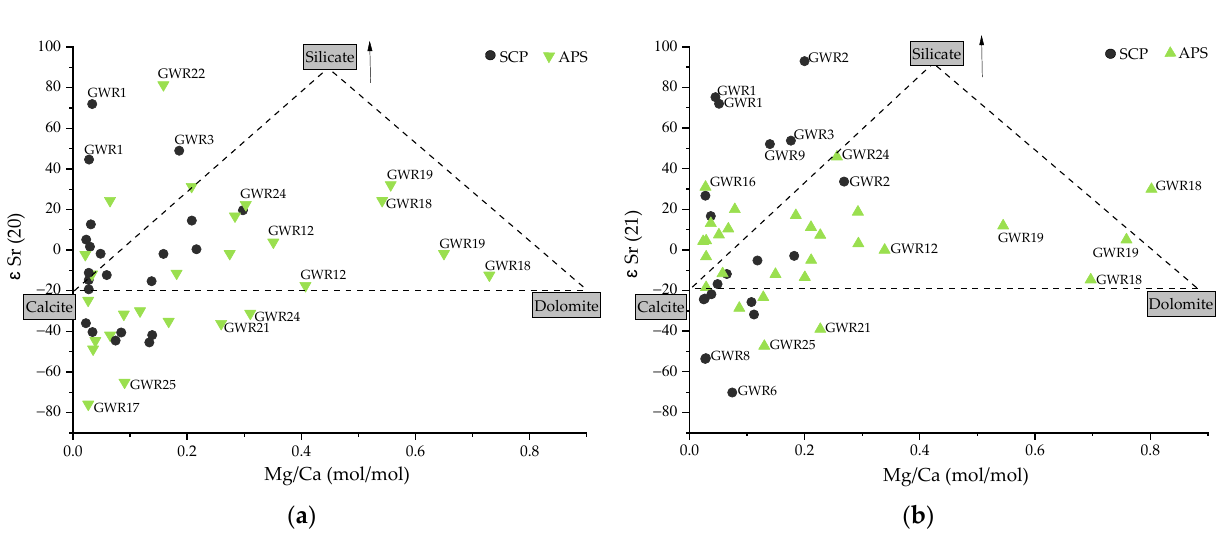
Figure 9. Diagram of ε Sr vs. Mg/Ca for the groundwater samples in the year 2020 ( a ), and 2021 ( b ).